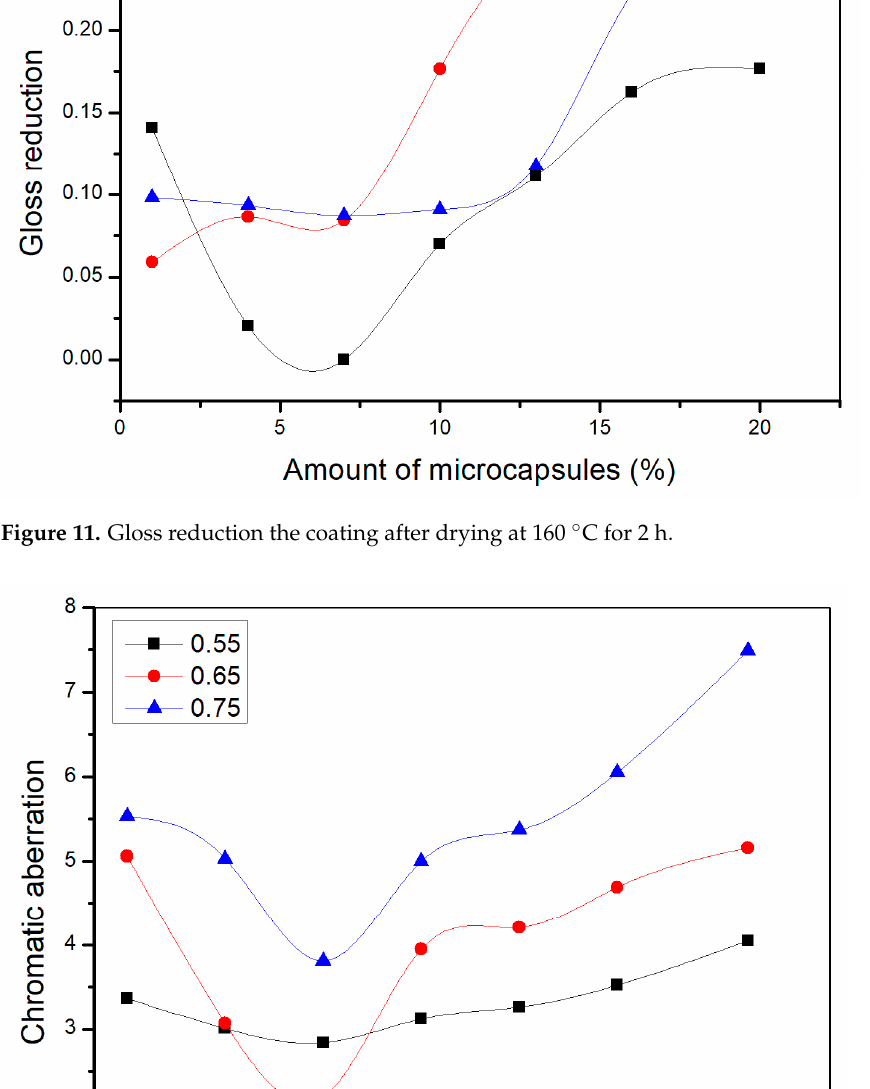
Figure 13. Chromatic aberration of the coating after drying at 140 °C for 2 h.